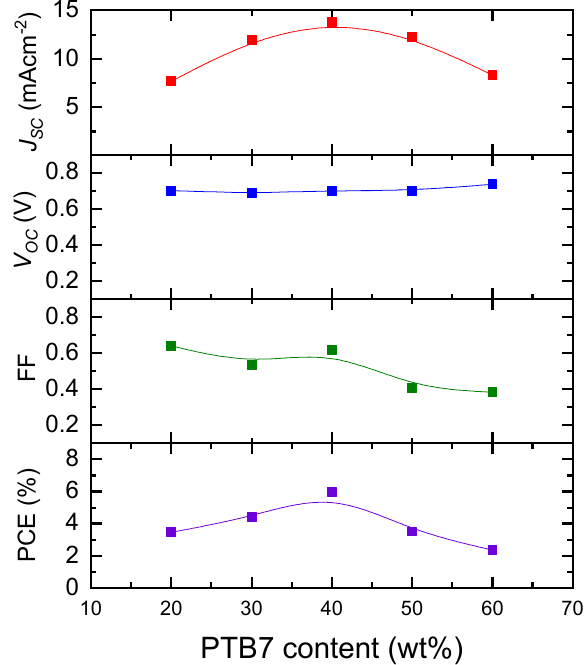
Figure 4. Dependence of photovoltaic performance (V oc , J sc , FF, and PCE) of PTB7:PC 71 BM inverted OPVs on PTB7 content.